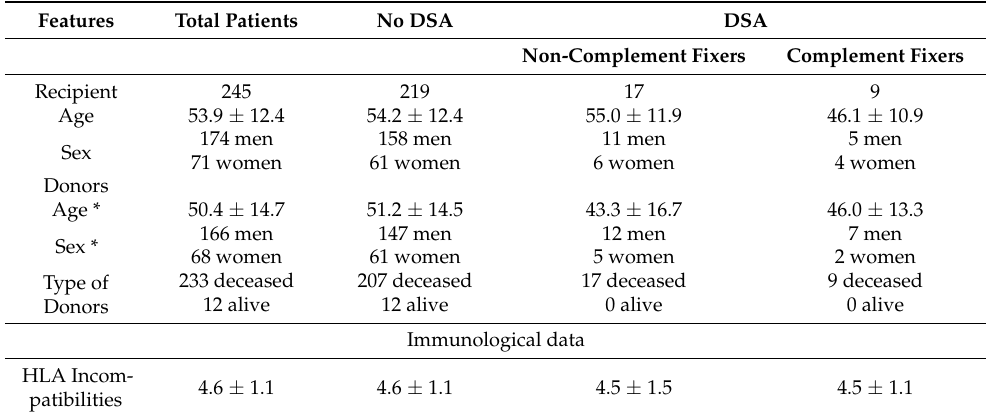
Table 2. Characteristics according to the presence or absence of DSA and its binding capacity to